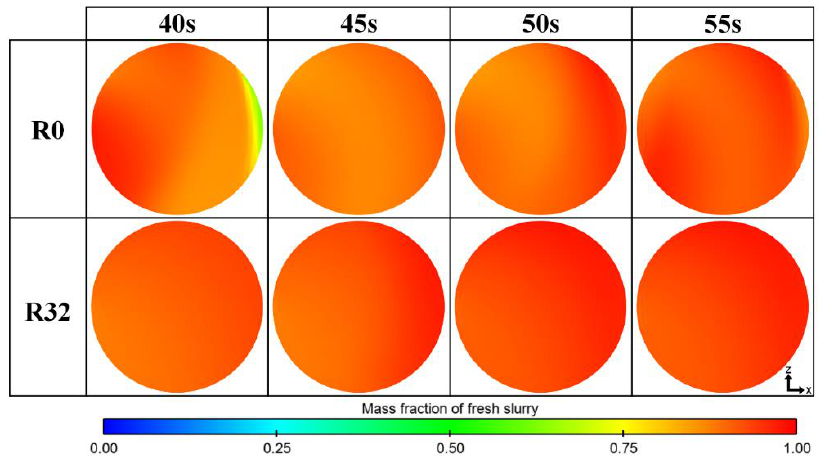
Figure 10. Simulated mass fraction of fresh slurry distribution in the wafer–pad interface with increasing flow time.